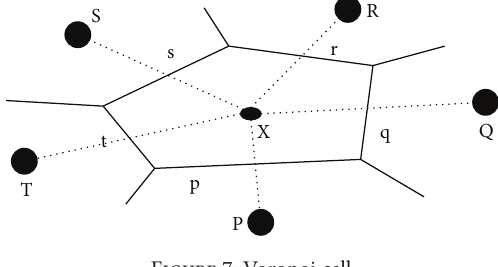
Figure 7: Voronoi cell.